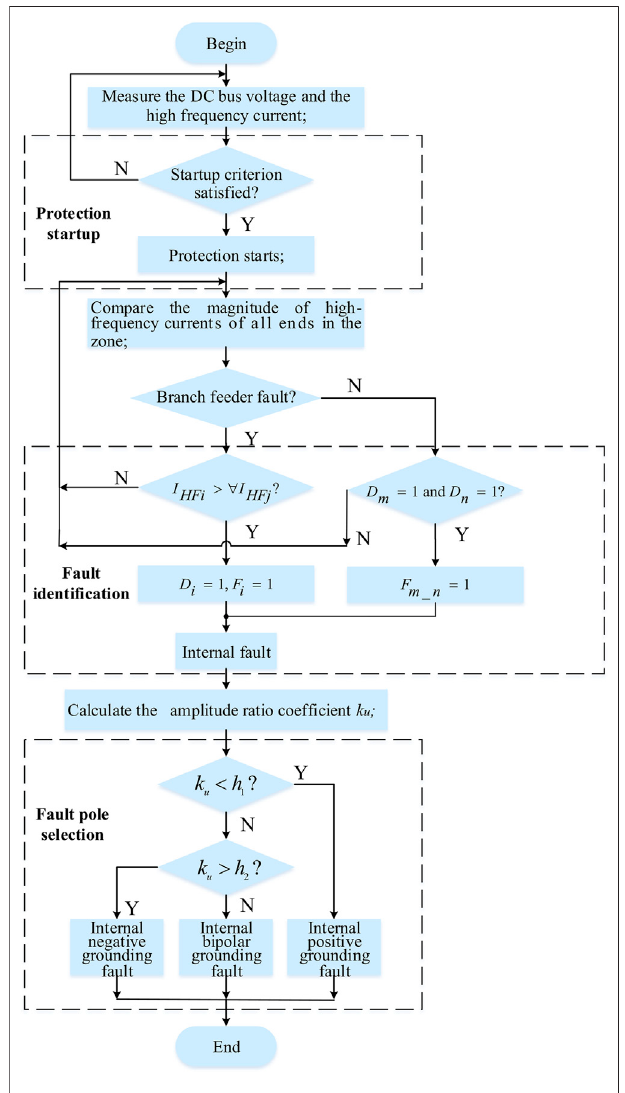
FIGURE 4 | Flow chart of the feeder protection